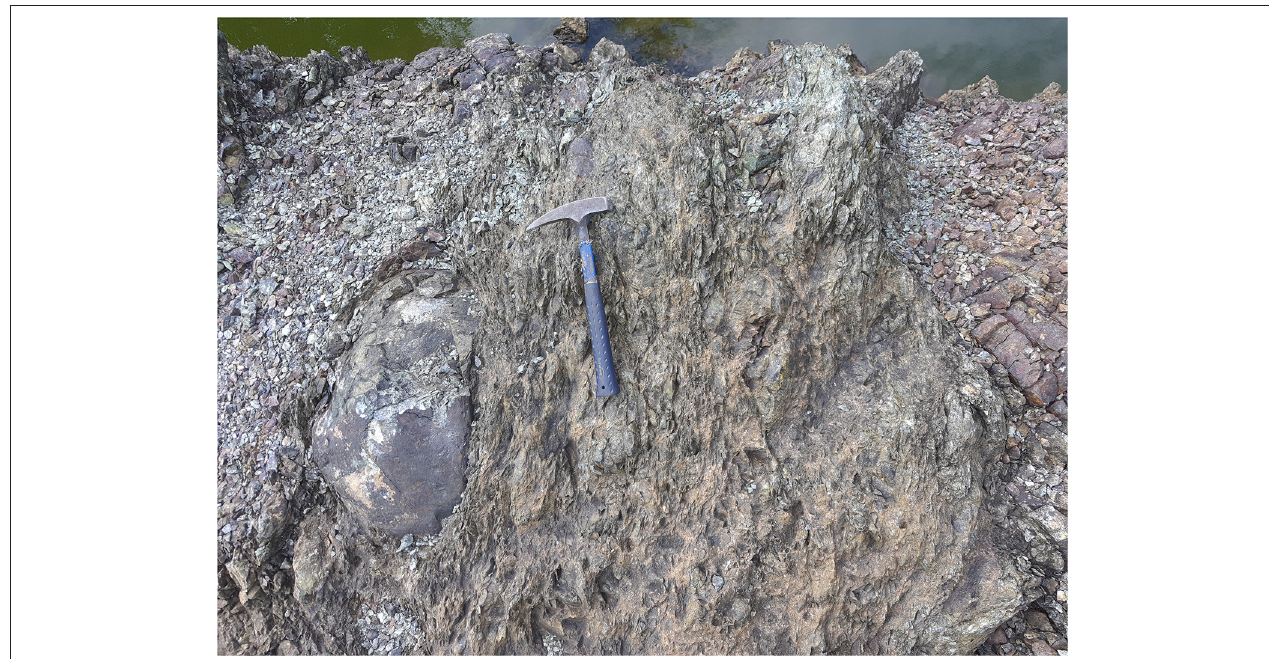
FIGURE 6 | Serpentinite outcrop from east of Pak Chom, Loei “Foldbelt,” N.E. Thailand with some areas showing original dunite texture. This and other outcrops of serpentinite mark the Loei Fault/ Suture separating the Loei-Phetchabun Terrane in the west from the Truong Son Terrane in the east in the Loei